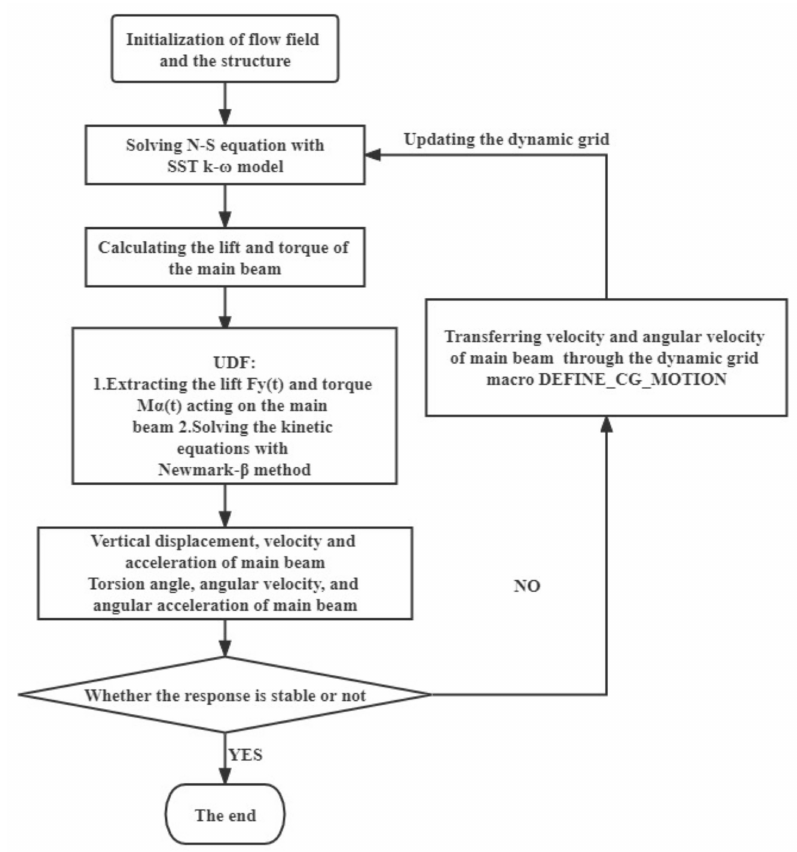
Figure 1. Flowchart of the calculation of the Newmark- β method embedded in